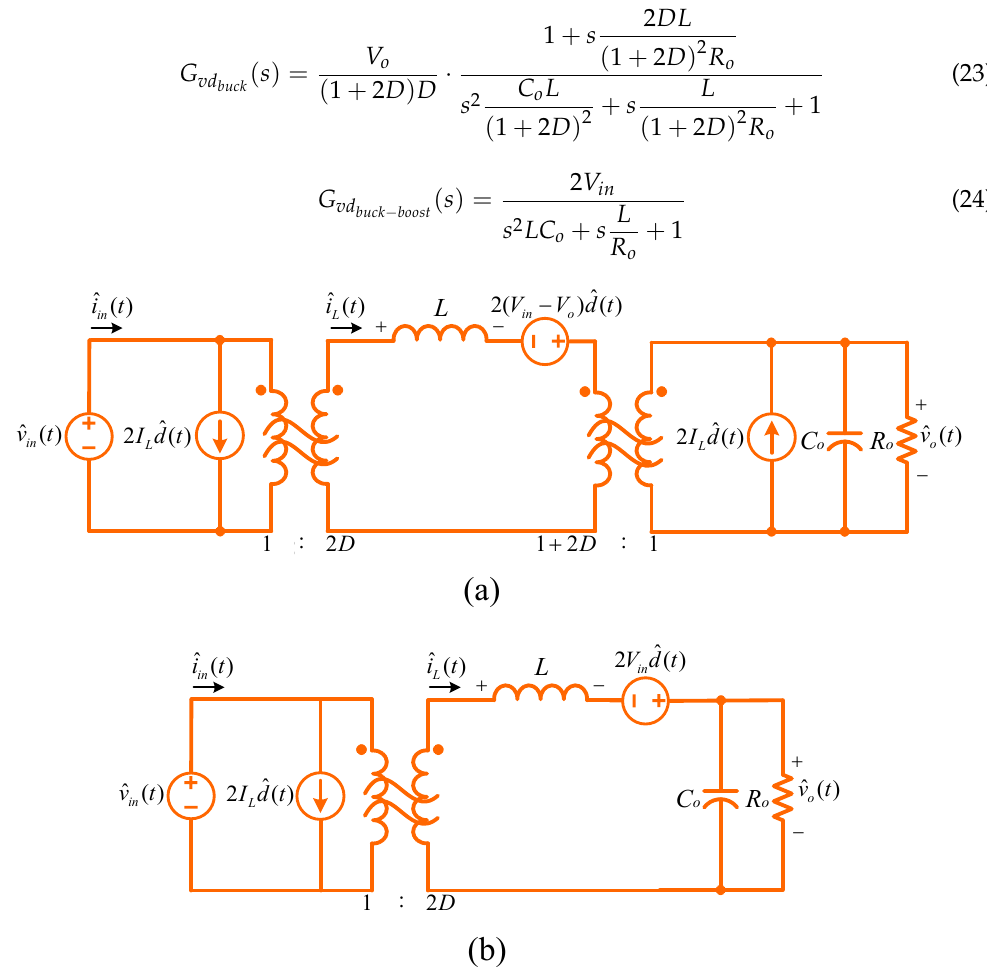
Figure 6. Small-signal AC equivalent circuit of the proposed step-down converters: ( a ) 3SSC-A-based buck; ( b ) 3SSC-A-based